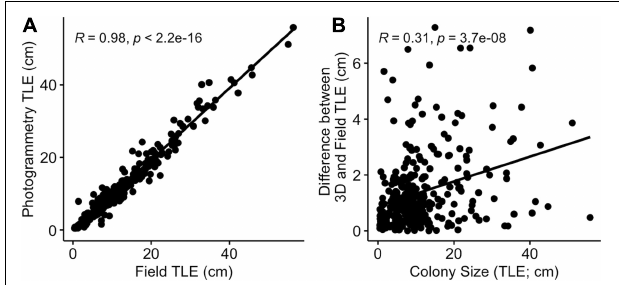
FIGURE 1 | The relationship between (A) TLE measured by-hand in the field and from 3D models and (B) the absolute difference between by-hand and 3D based measures and the size of the focal coral colony ( n =